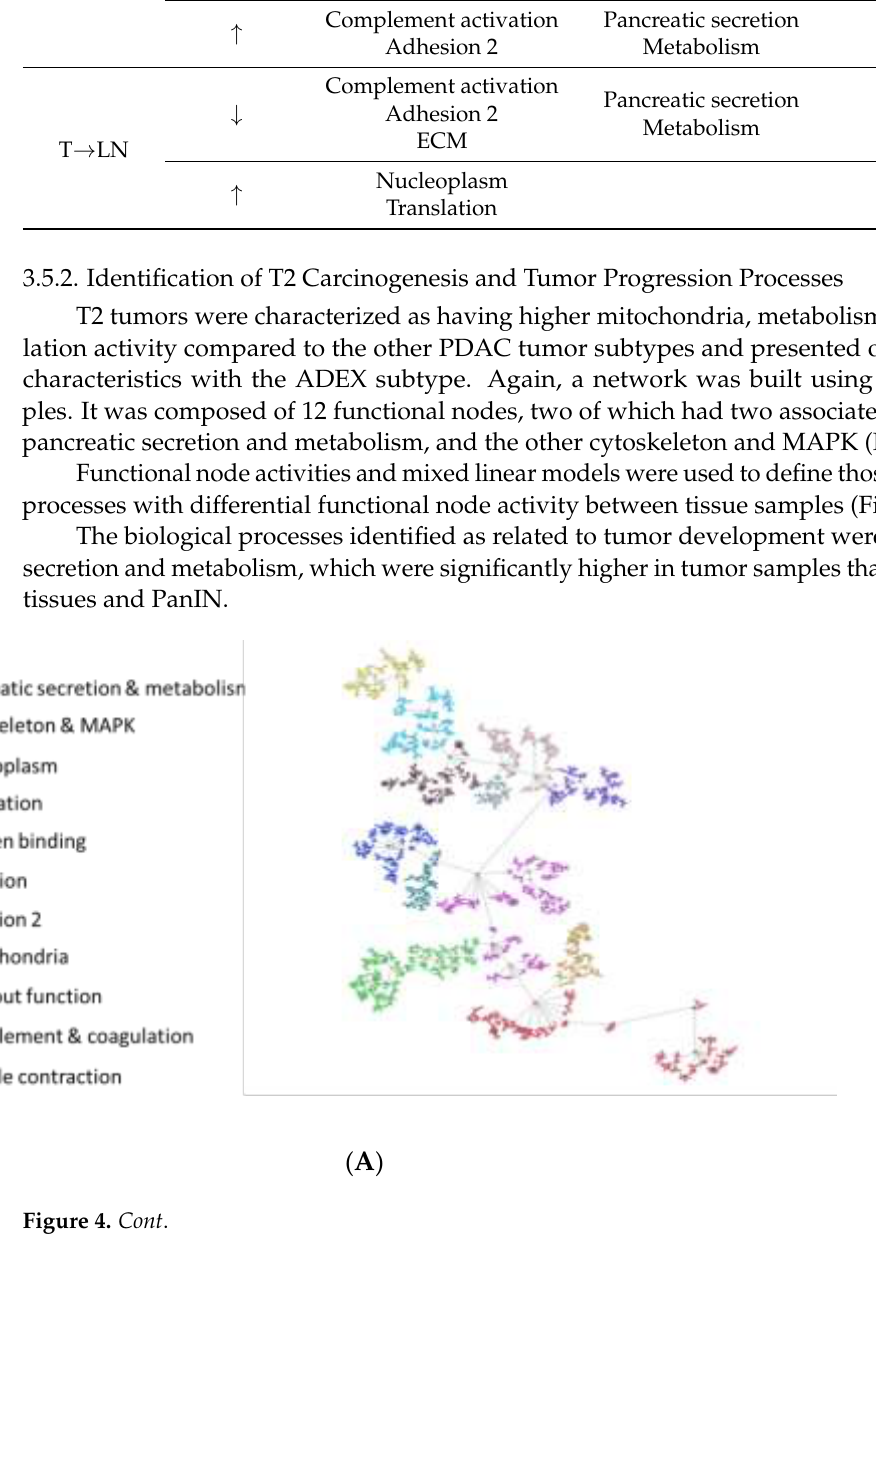
( B ) Figure 4. ( A ). Network of 2311 proteins in the T2 subtype. ( B ) Differential functional node activities comparing the different histological samples in the T2 subtype according to mixed lineal models. NT = normal tissue, P = preneoplastic lesions, T = primary tumors, LN = lymph nodes. * p < 0.05. The biological processes identified as related to tumor development were pancreatic secretion and metabolism, which were significantly higher in tumor samples than in nor- mal tissues and PanIN. These functional node activities (pancreatic secretion and metabolism) presented a significant decrease in lymph node samples compared to tumors, which could be associ- ated with tumor progression. Pancreatic secretion node contained several relevant proteins such as TYMP, NAMPT, or pancreatic lipases, such as PNLIP. 3.5.3. Identification of T3 Carcinogenesis and Tumor Progression Processes T3 subtype was characterized by higher nucleoplasm activity and also had overlap- ping characteristics with the classical subtype. The obtained network using protein ex- pression data from the T3 samples was composed of ten functional nodes (Figure 5A). Functional node activities showed differences between no tumor and tumor samples in nucleoplasm, mitochondria and metabolism, and ECM. ECM had a decrease in their activity in tumors compared to normal samples, while nucleoplasm showed an increase in tumor samples. In addition, tumor samples presented a decrease in mitochondria and metabolism node activity compared to PanIN. In the case of tumor and lymph nodes, there are no significantly different processes between them (Figure 5B). Nucleoplasm nodes were formed by some well-known proteins, such as PARP1, ELAVL1, SART3, RAN, FUBP1, APEX1, or AKT1S1.